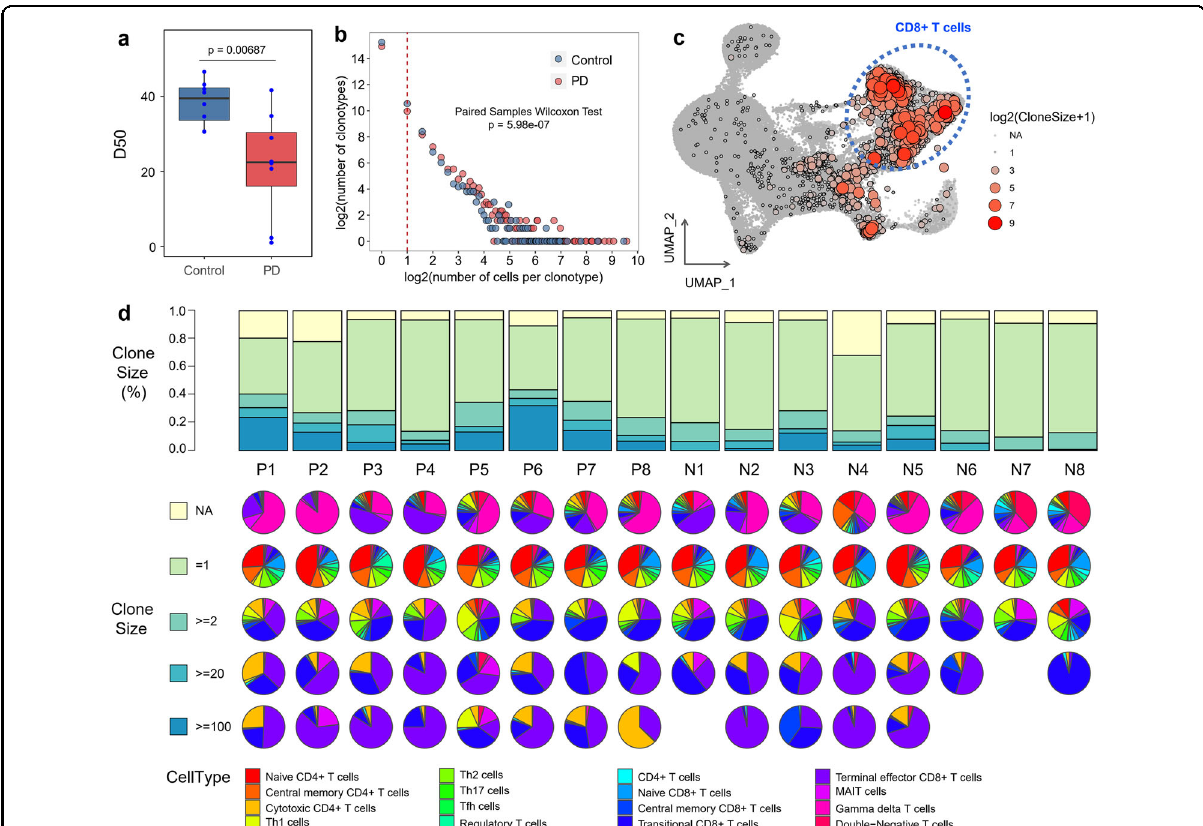
Fig. 2 Single-cell immune pro fi ling of T cells. a Blood TCR diversity comparison between PD patients and healthy controls. TCR diversity was measured by D50, which is proven robust for the sequencing library size. P value was estimated using two-sided Wilcoxon test. b The association between the number of T cell clonotypes and the number of cells per clonotype. Downsampling was used to avoid bias caused by the total number of detected T cells between PD patients and healthy controls. The dashed line separates nonclonal and clonal cells, with the latter identi fi ed by repeated usage of αβ TCRs. P value was estimated using paired samples Wilcoxon test. c UMAP plot showing the distribution of clonally expanded T cells. Each dot represents a unique clonotype in a T cell cluster, and the coordinates are the average coordinates of the cells belonging to this clonotype. The color and size of the dot both re fl ect the clone size in each cluster. d Clonal composition of T cells in samples. The top panel shows the distribution of clonotypes by size (NA, = 1, ≥ 2, ≥ 20 and ≥ 100 cells, NA represents cells with no αβ TCR sequence detected). The bottom pie charts show the cell type composition of clonotypes from each sample strati fi ed by clone